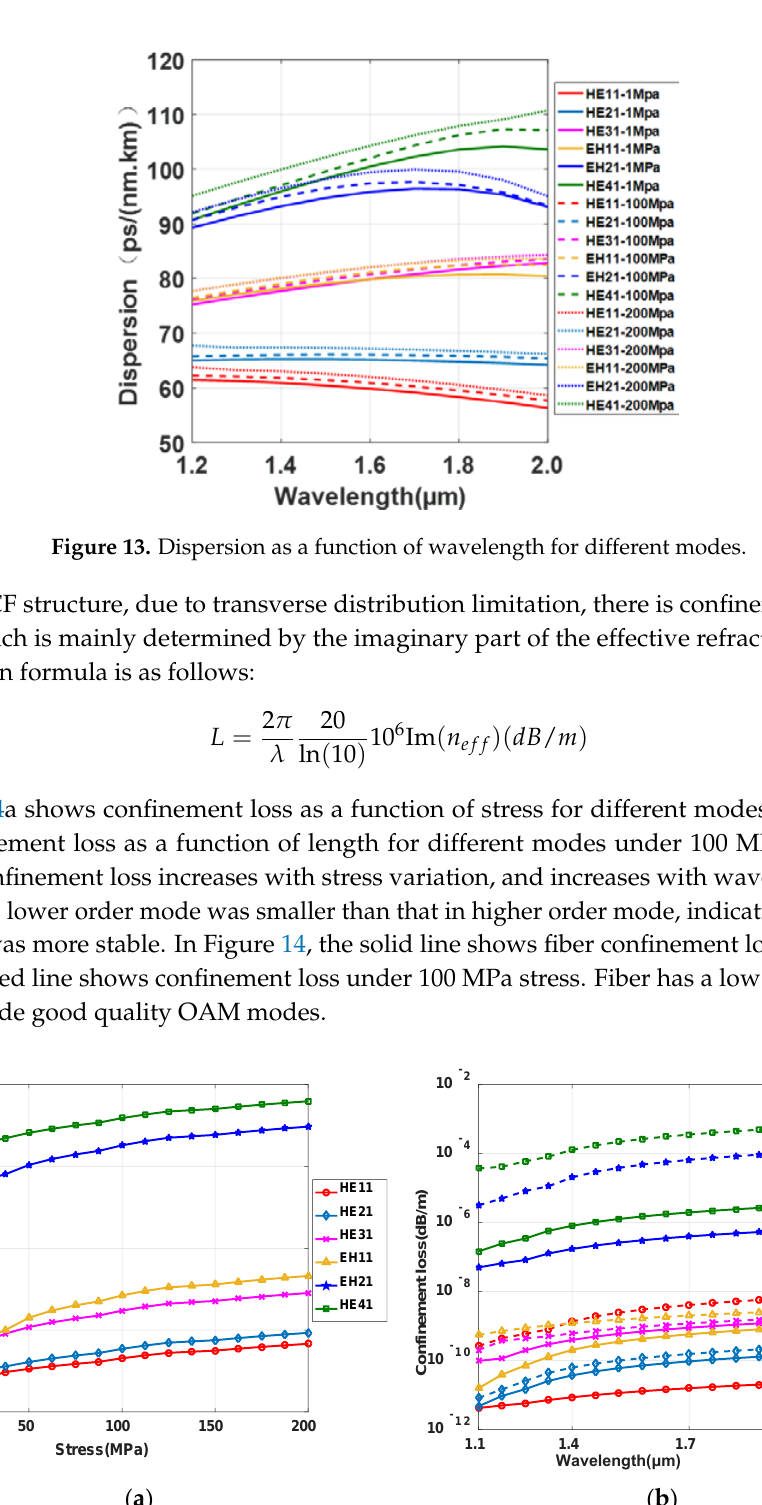
Figure 14. ( a ) Confinement loss as a function of stress for different modes, and ( b ) confinement loss as a function of length for different modes under 100 MPa stress in the y direction.